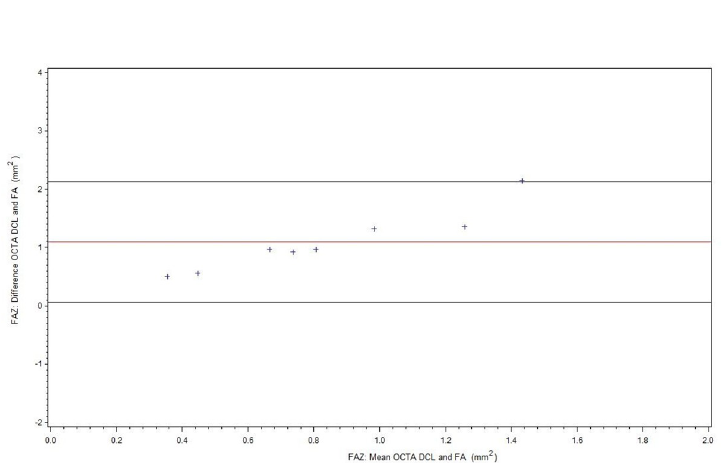
Fig 6. FAZ: Bland-Altman-Plot for the agreement of FA and OCTA DCL in patients without ME.